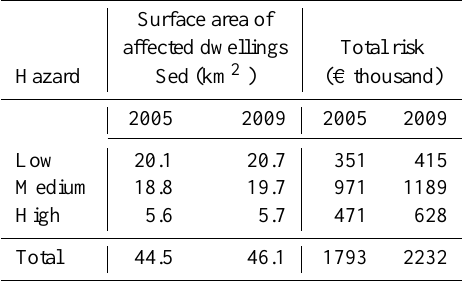
Table 10. Surface area of affected dwellings and total risk according to hazard.